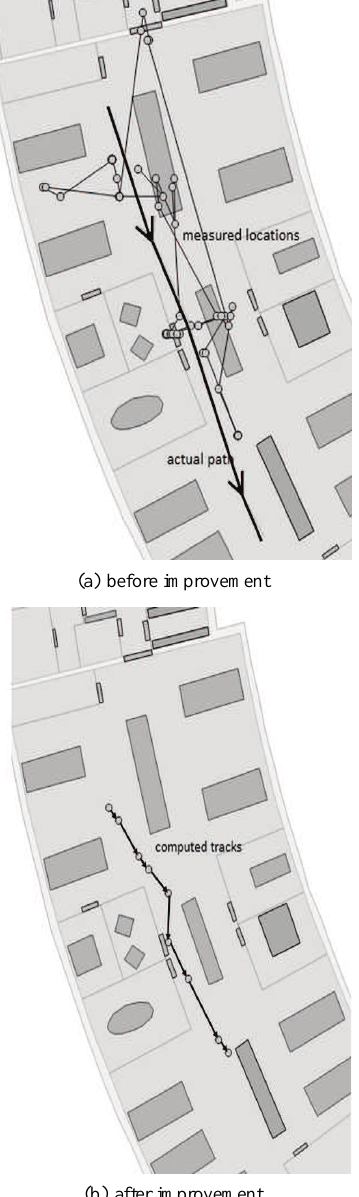
Figure 6: Walking inside a Space Figure 7: Walking between Two Spaces